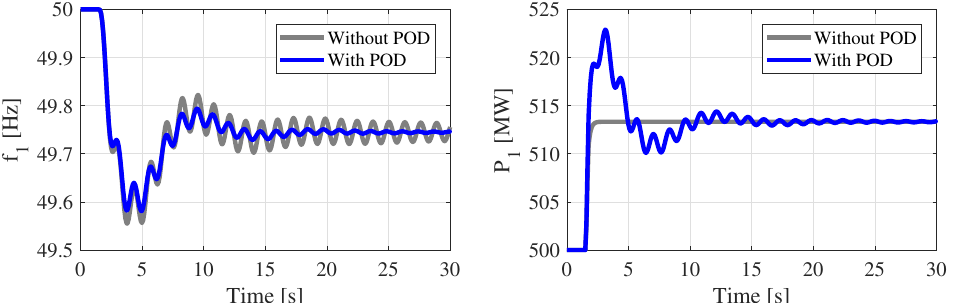
Figure 10. Onshore frequency, f 1 , and power fed by VSC1, P 1 , when using AFC (Case C) in parallel with a POD